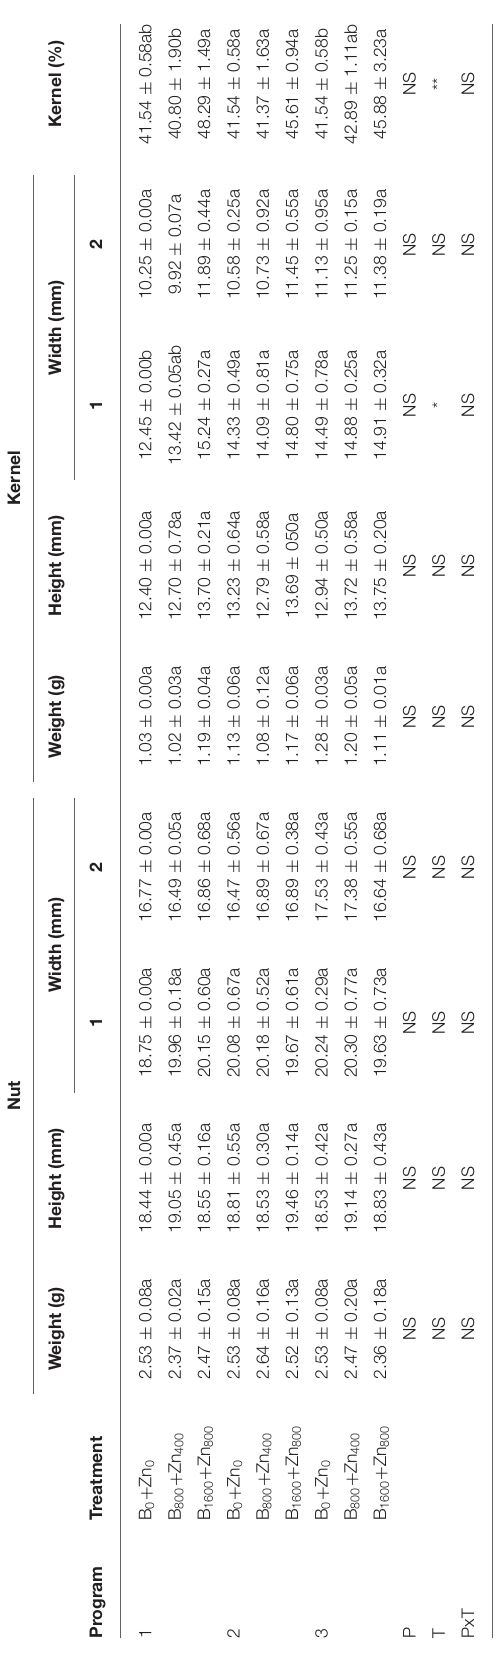
TABLE 4 | Some nut shell properties after application of B and Zn spraying programs in hazelnut cultivar TDG planted in La Araucanía region.